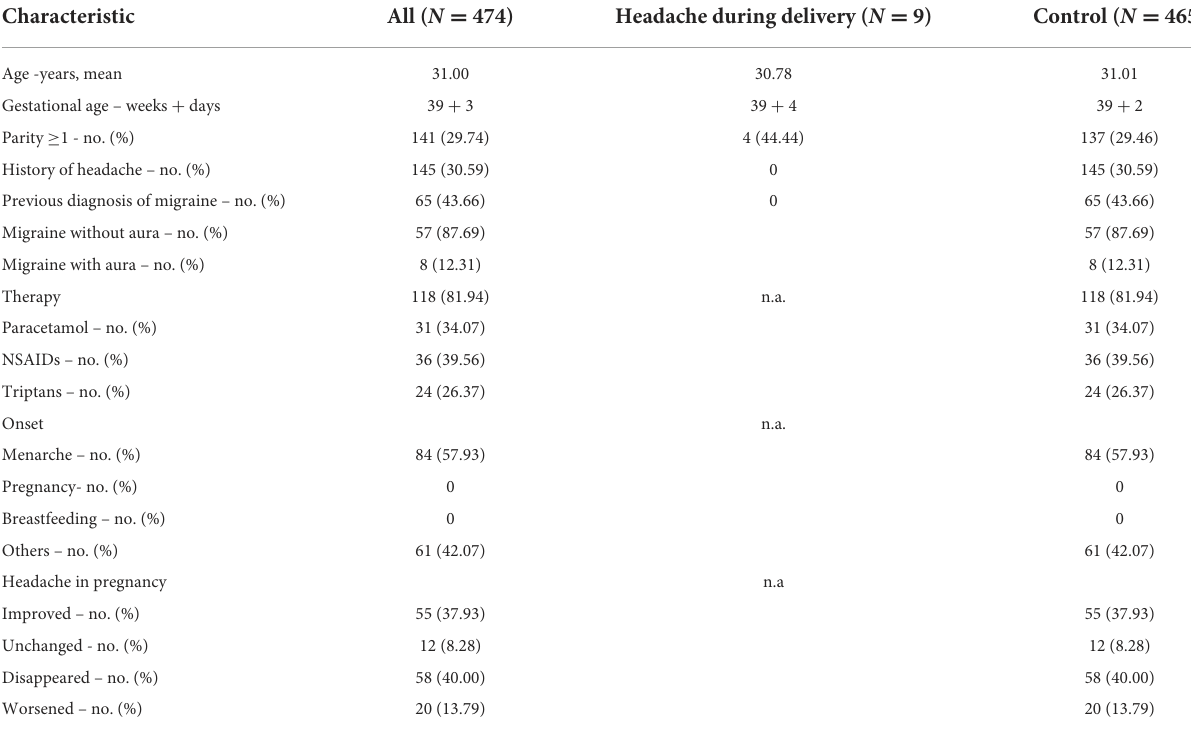
TABLE 3 Patient characteristics and headache features before